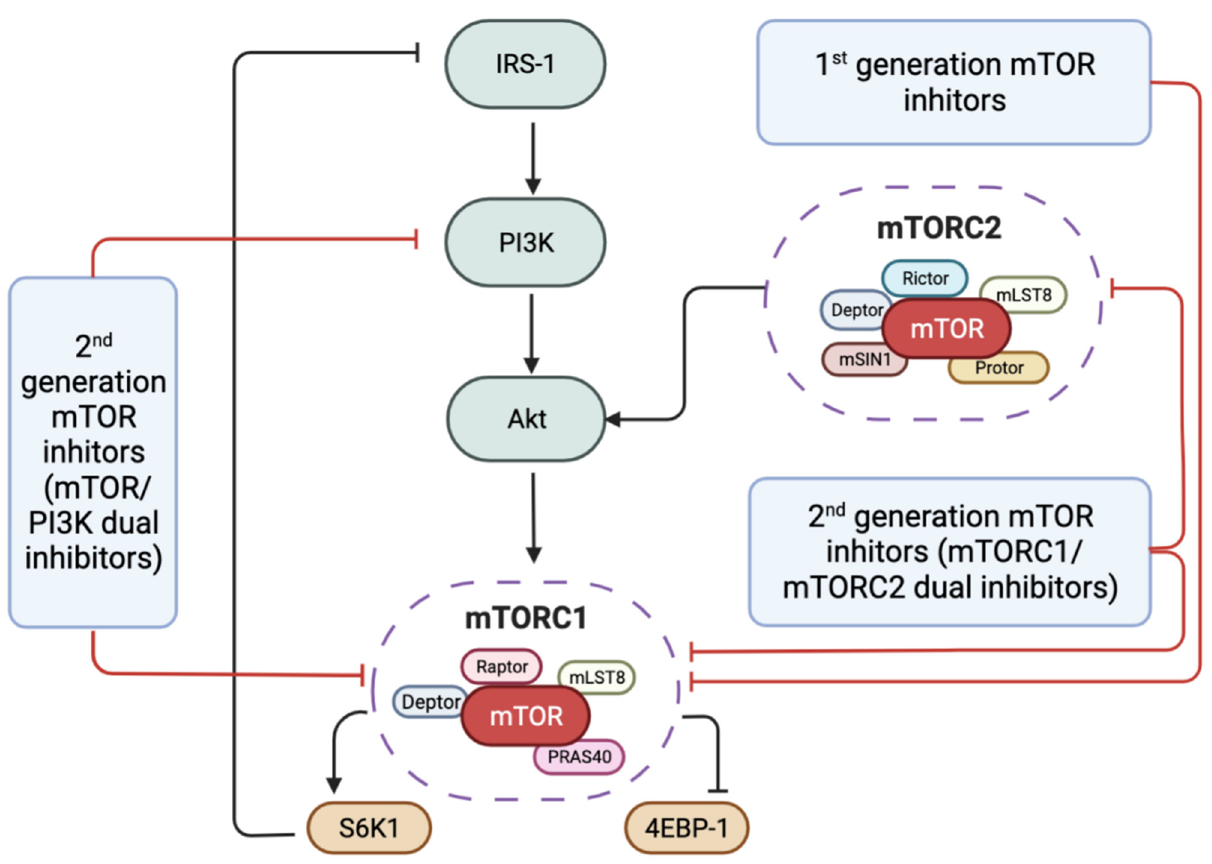
Figure 3. The signalling pathway that is modulated by different generation mTOR inhibitors. Inhi- bition of mTORC1 results in the suppression of 4E-BP1 and S6K1 phosphorylation. Inhibited S6K1 reduces protein synthesis through phosphorylation of the 40S ribosomal subunit, which has been suggested to decrease the translational efficiency of a class of mRNA transcripts with a 5 ′ -terminal oligopolypirymidine. There is a negative feedback loop in which mTORC1 activation can inhibit the PI3K pathway by S6K1-mediated phosphorylation and degradation of IRS-1, and it fills an impor- tant gap in our understanding the underlying mechanisms by which mTORC1 inhibits PI3K-Akt signalling. Abbreviations: IRS-1, insulin receptor substrate 1; PI3K, phosphatidylinositol-3-kinase; AKT, protein kinase B; PRAS40, proline-rich AKT substrate of 40 kDa; mTOR, mammalian target of rapamycin; S6K1, S6 kinase 1; 4E-BP1.